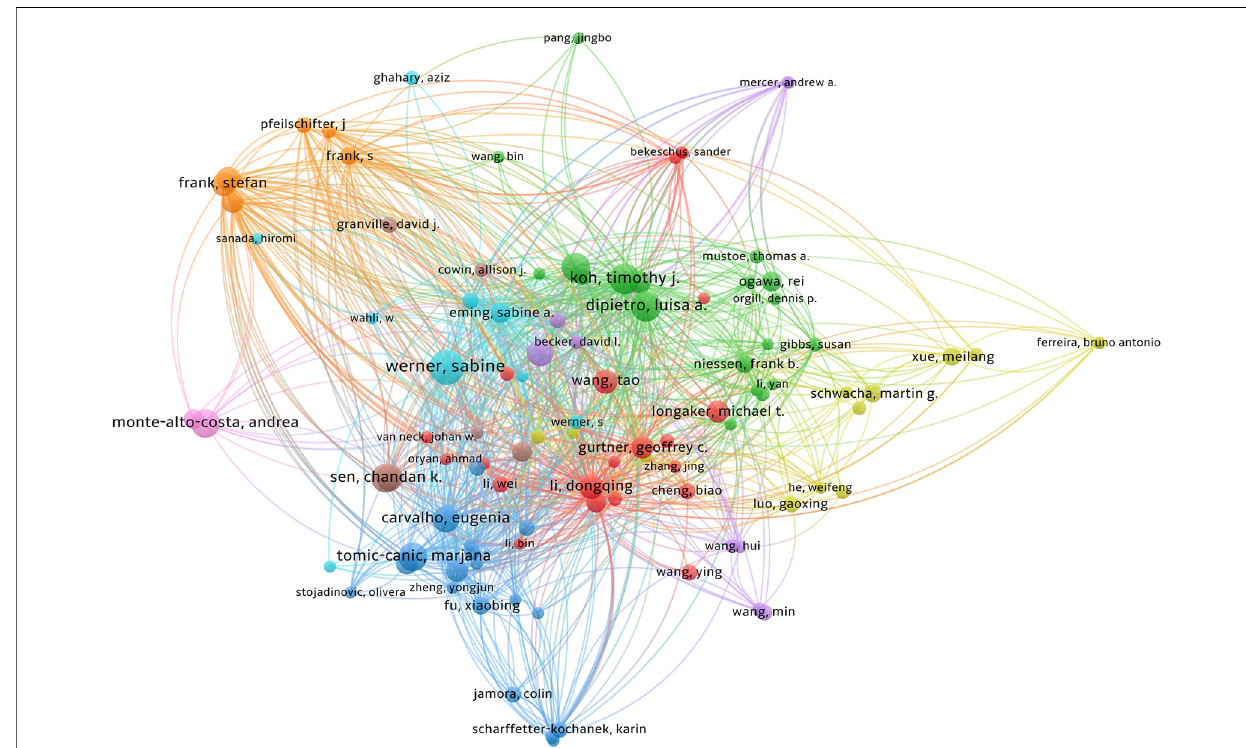
FIGURE 5 The co-authorship network of authors. A total of 21,144 authors participated in the writing process. The analysis method is Lin Log/modular. The size of the circle represents the in fl uence of the author. Internode connections represent author collaboration and the lines of connection between nodes represent the collaboration between